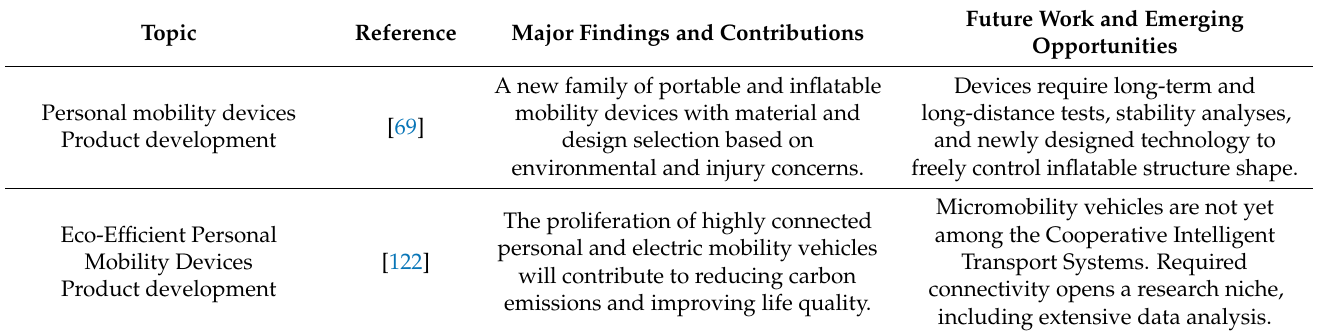
Table 1. Overview of the significant contributions of the cited works related to socio-economic